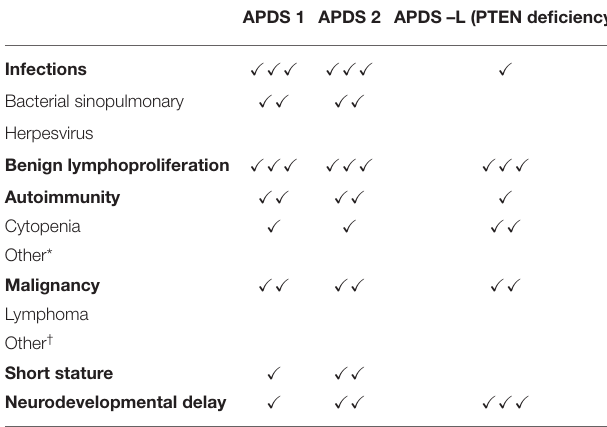
Age of Onset and Progression of Symptoms